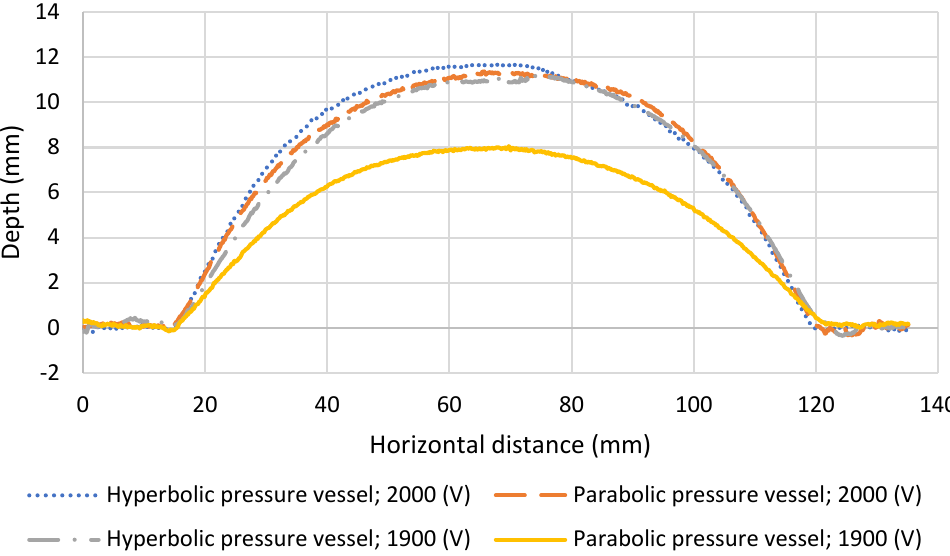
Figure 16. Comparison of pressure vessel shape to charging voltage when an auxiliary plate is placed under an AZ31 plate.